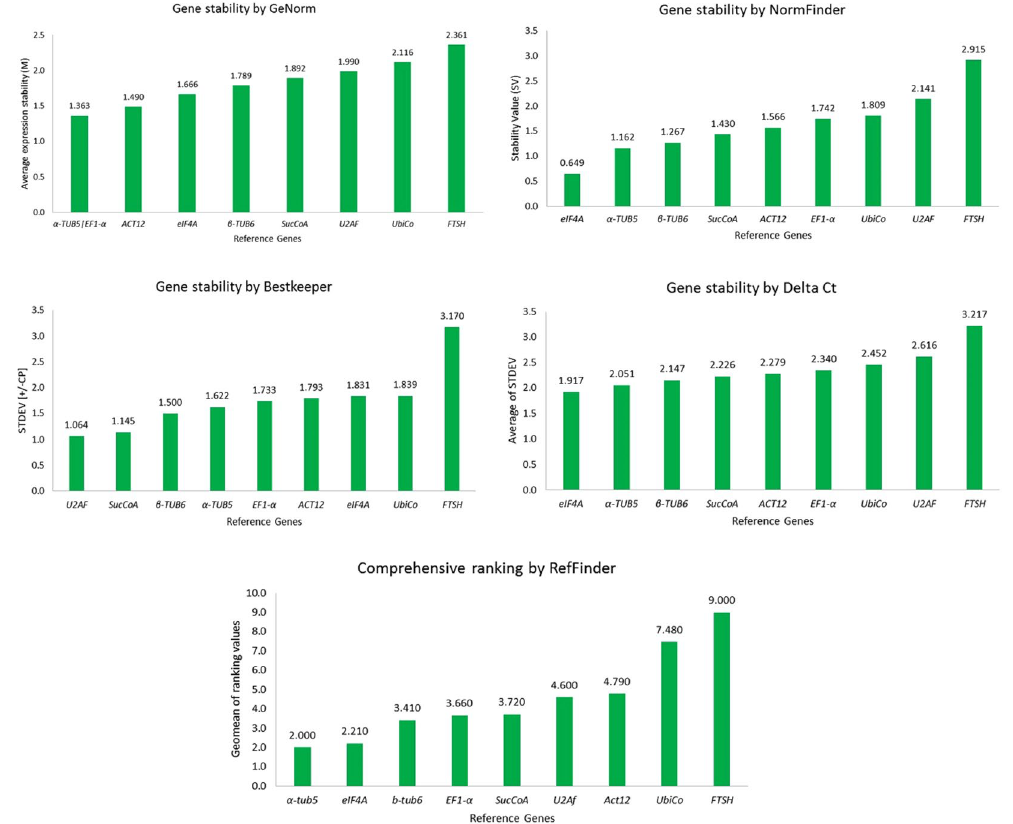
Figure 4. Rank of the candidate genes for all treatments combined (heat, cold and drought) generated by RefFinder web-tool showing the values for each of the four different algorithms. Δ Ct method (Mean SD), NormFinder (Stability value), geNorm (Average expression stability M), BestKeeper (SD [ ± CP] crossing point values) and the final comprehensive